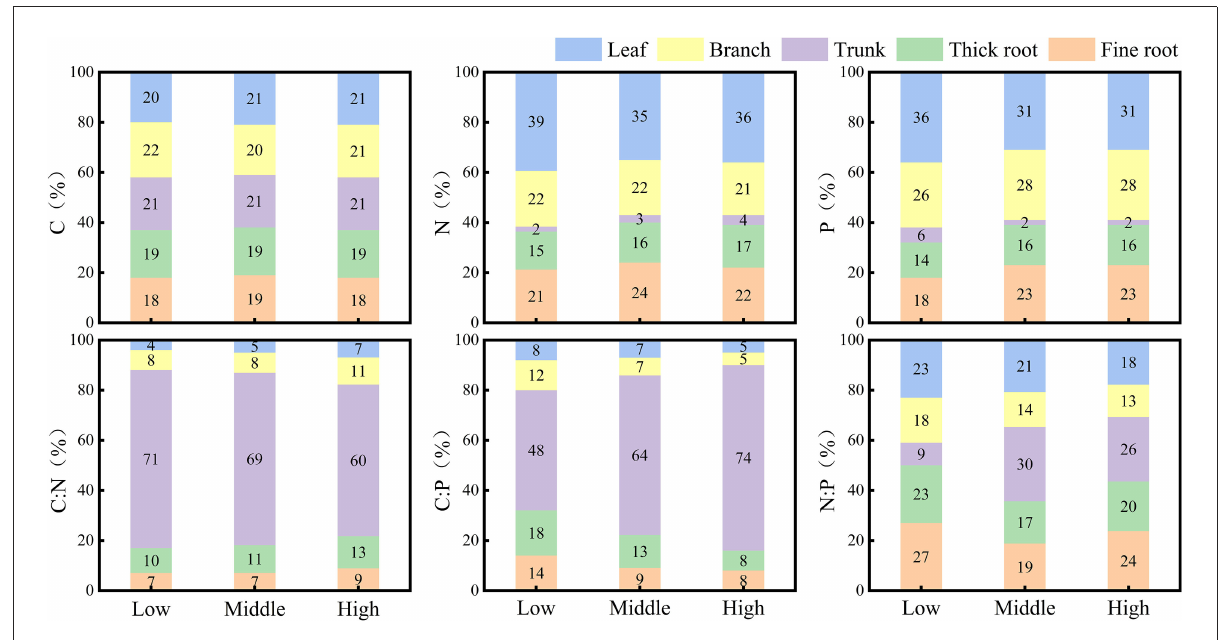
FIGURE4 Distribution of stoichiometry measures among the tissue types of Qinghai spruce at different